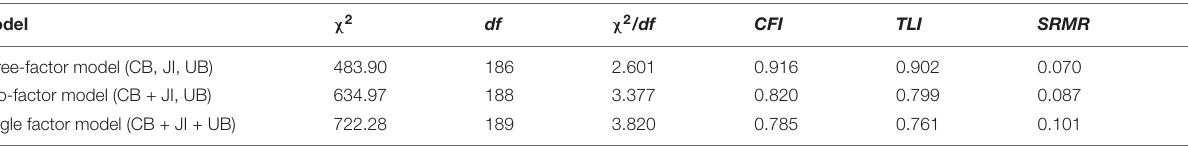
CB, Customer bullying; JI, Job insecurity; UB, Unethical behaviors. TABLE 4 | Means, standard deviations, correlations among the study variables.